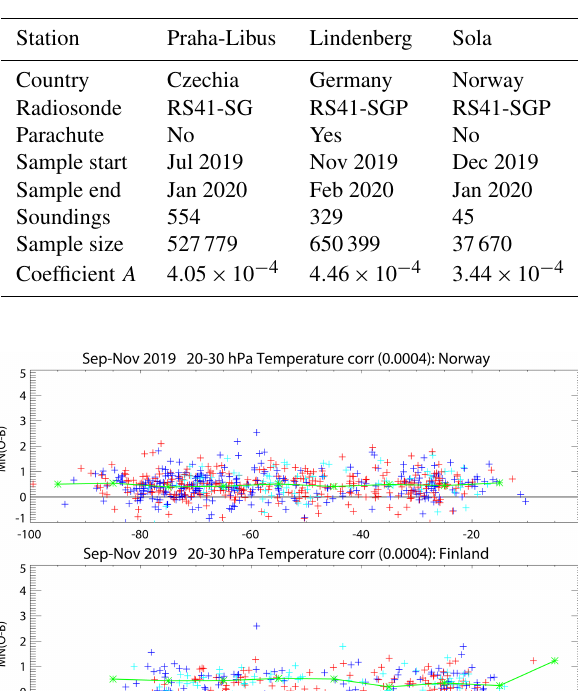
Table 4. The coefficient A determined from different samples.